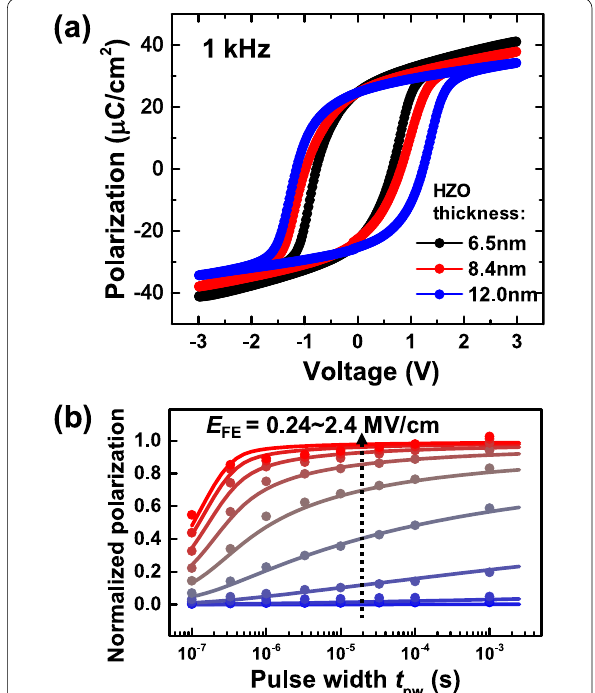
Fig. 4 ( a ) Measured P – V curves of the HZO capacitors with HZO thicknesses of 6.5 nm, 8.4 nm, and 12.0 nm at 1 kHz, ( b ) measured normalized polarization curves versus pulse width t pw as a function of applied electric field E FE . for the 8.4 nm-thick HZO capacitor